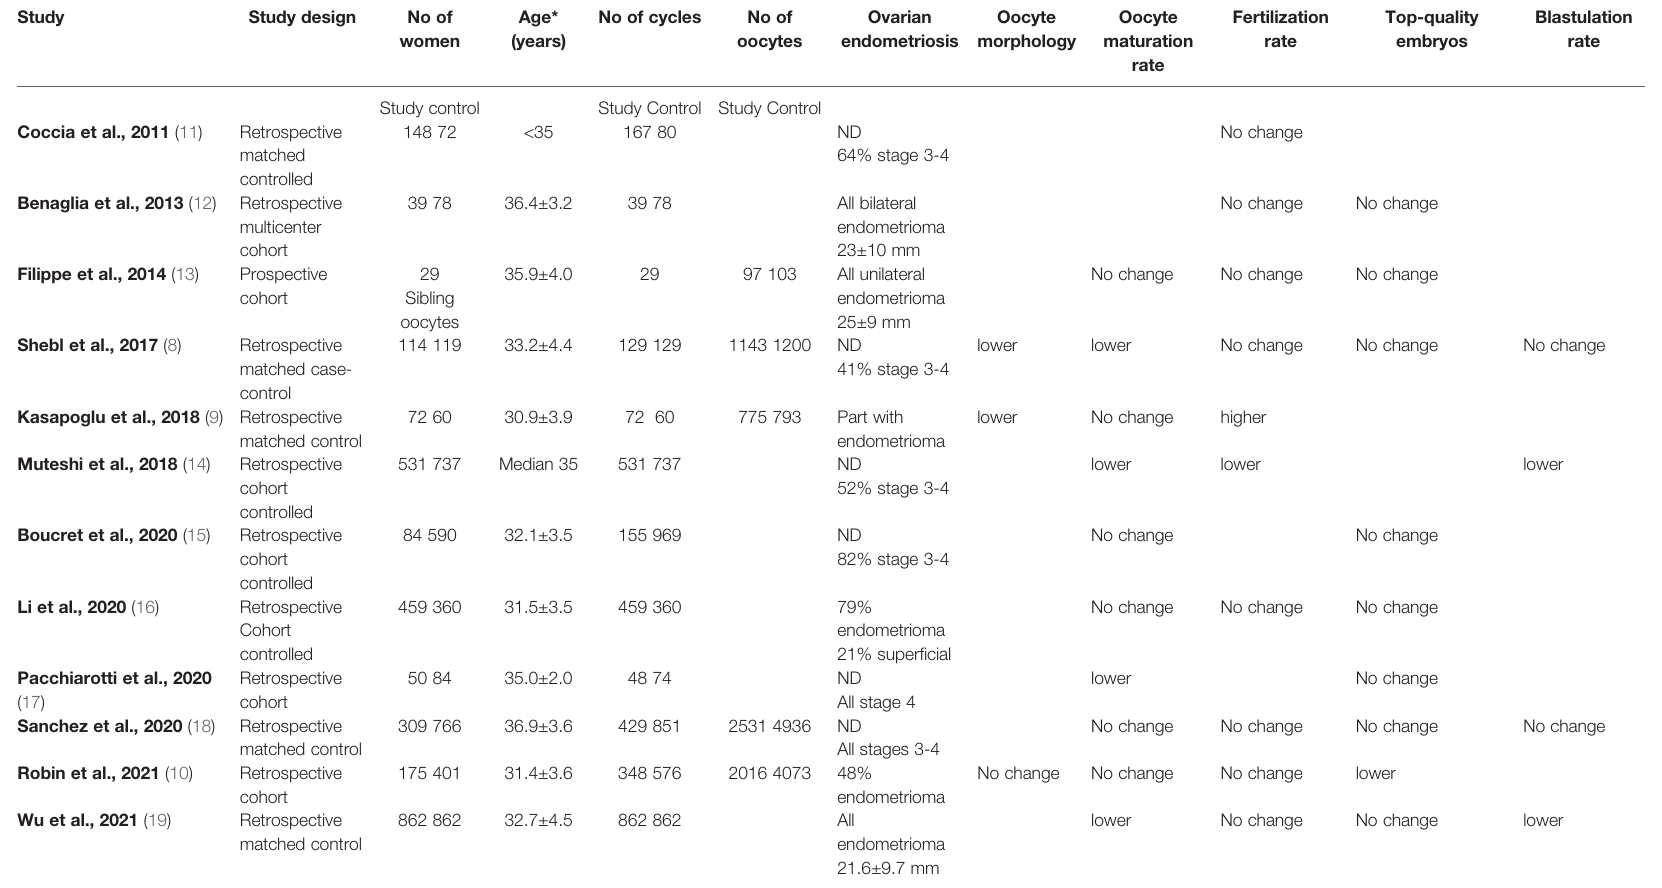
TABLE 1 | Oocyte quality and embryo development in infertile women with endometriosis as compared to controls.